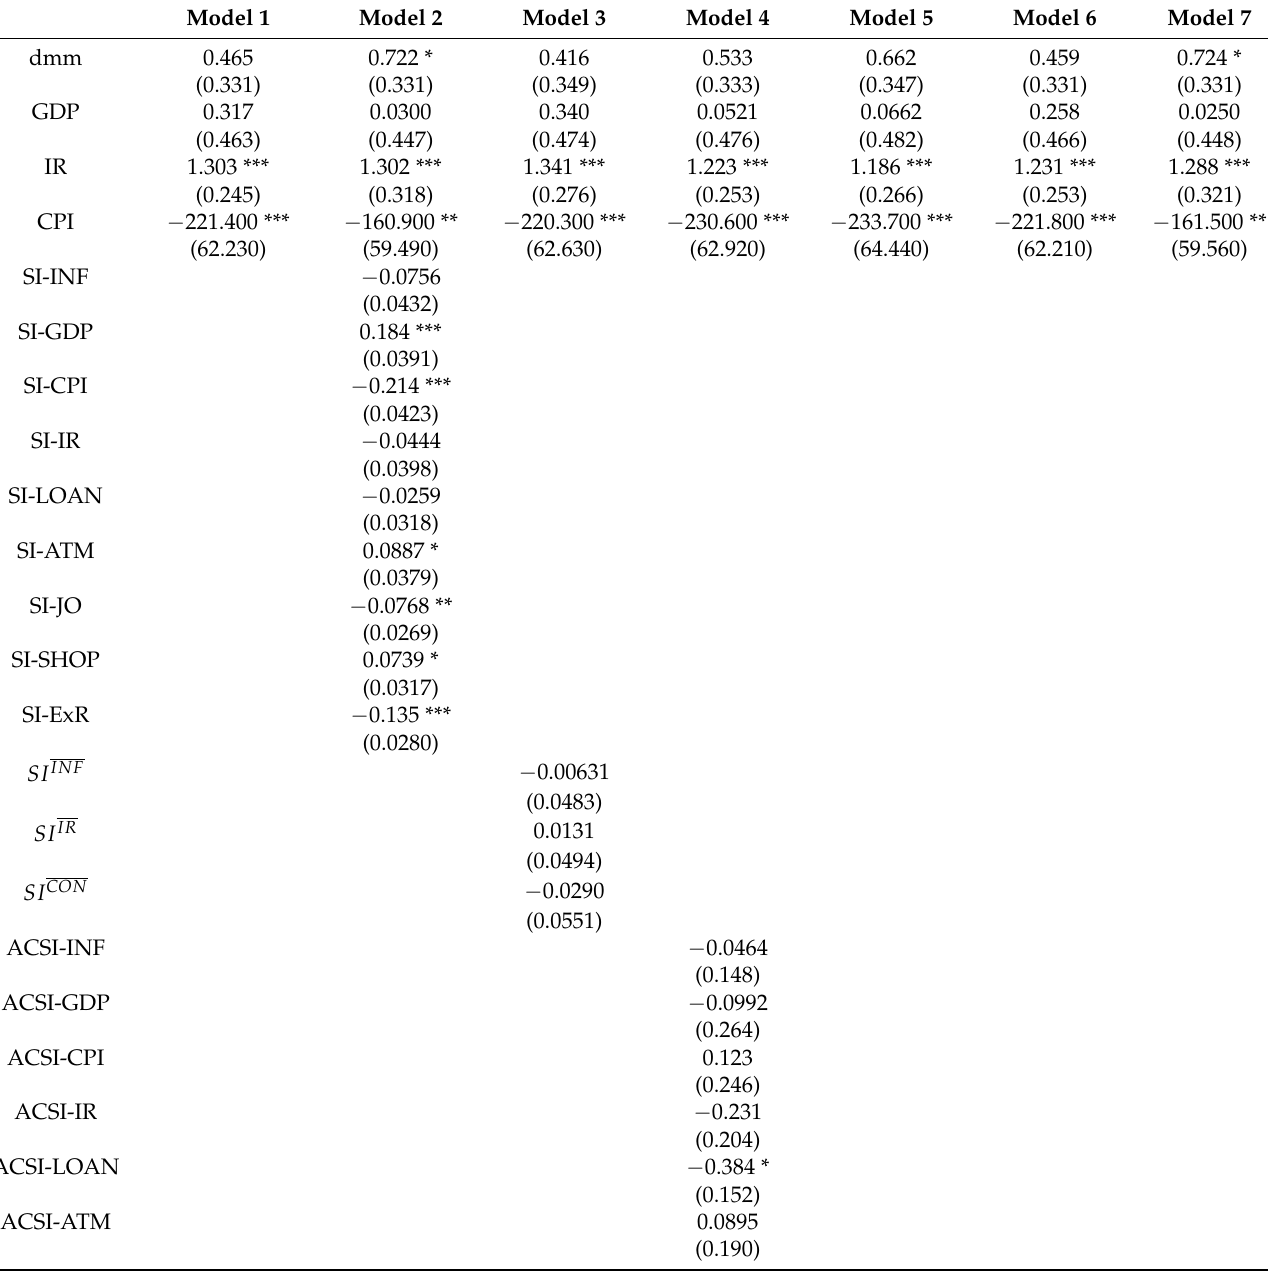
Table 3. Panel Regression Table Fixed-Effects OM